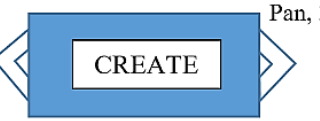
Figure 10. Secure Element Output.